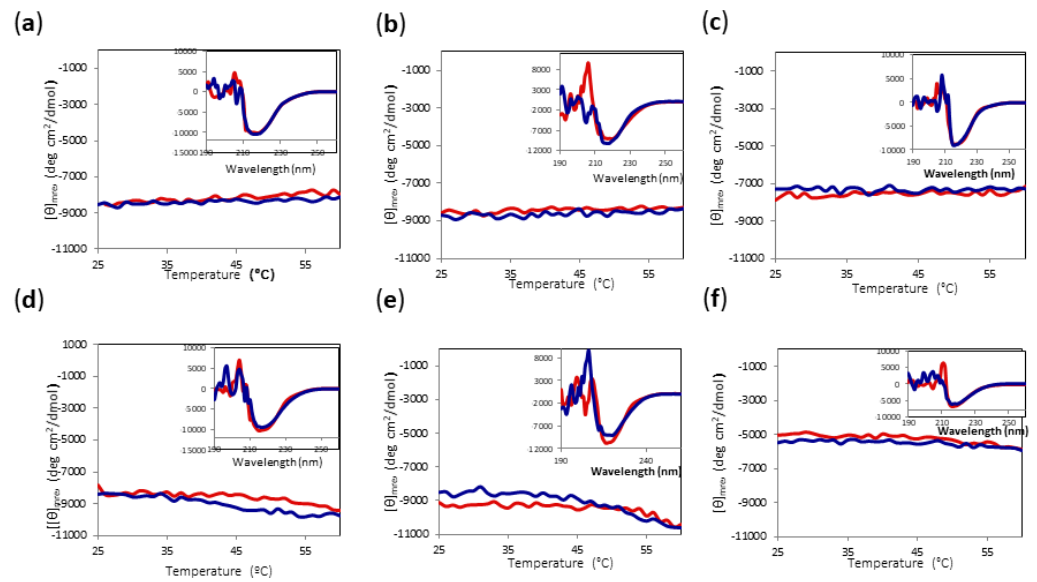
Figure 7. CD temperature scans of Amy A from 25 °C to 60 °C in different choline chloride:urea (1:2) DES and MeOH concentrations. Main chart: Amy A heating signal (red) and cooling signal (blue) at 220 nm. Inset: Far UV-CD spectra before heating (red) and after cooling (blue). ( a ) 60% DES, 10% MeOH; ( b ) 70% DES, 10% MeOH; ( c ) 80% DES, 10% MeOH; ( d ) 60% DES, 20% MeOH; ( e ) 70% DES, 20% MeOH; ( f ) 80% DES, 20% MeOH.